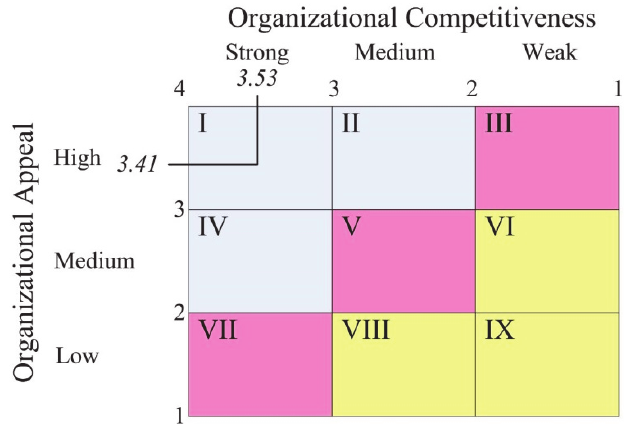
Fig. 3. Strategic Position of Bongkasa Pertiwi Tourism Village